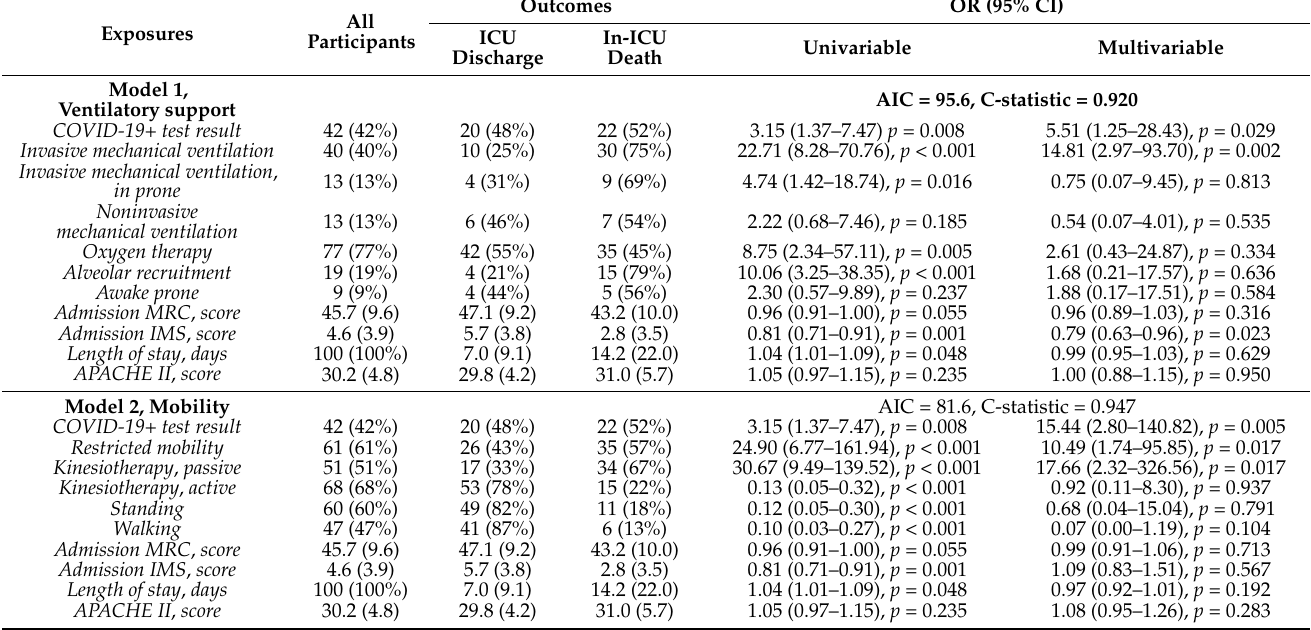
Mean (SD), absolute frequency (%) or odds ratio (OR) with 95% confidence interval (95% CI). AIC: Akaike information criterion. MRC: Medical Research Council. IMS: Intensive care unit Mobility Scale. Bold formatting represents overall model results. Italic formatting represents individual variables within a